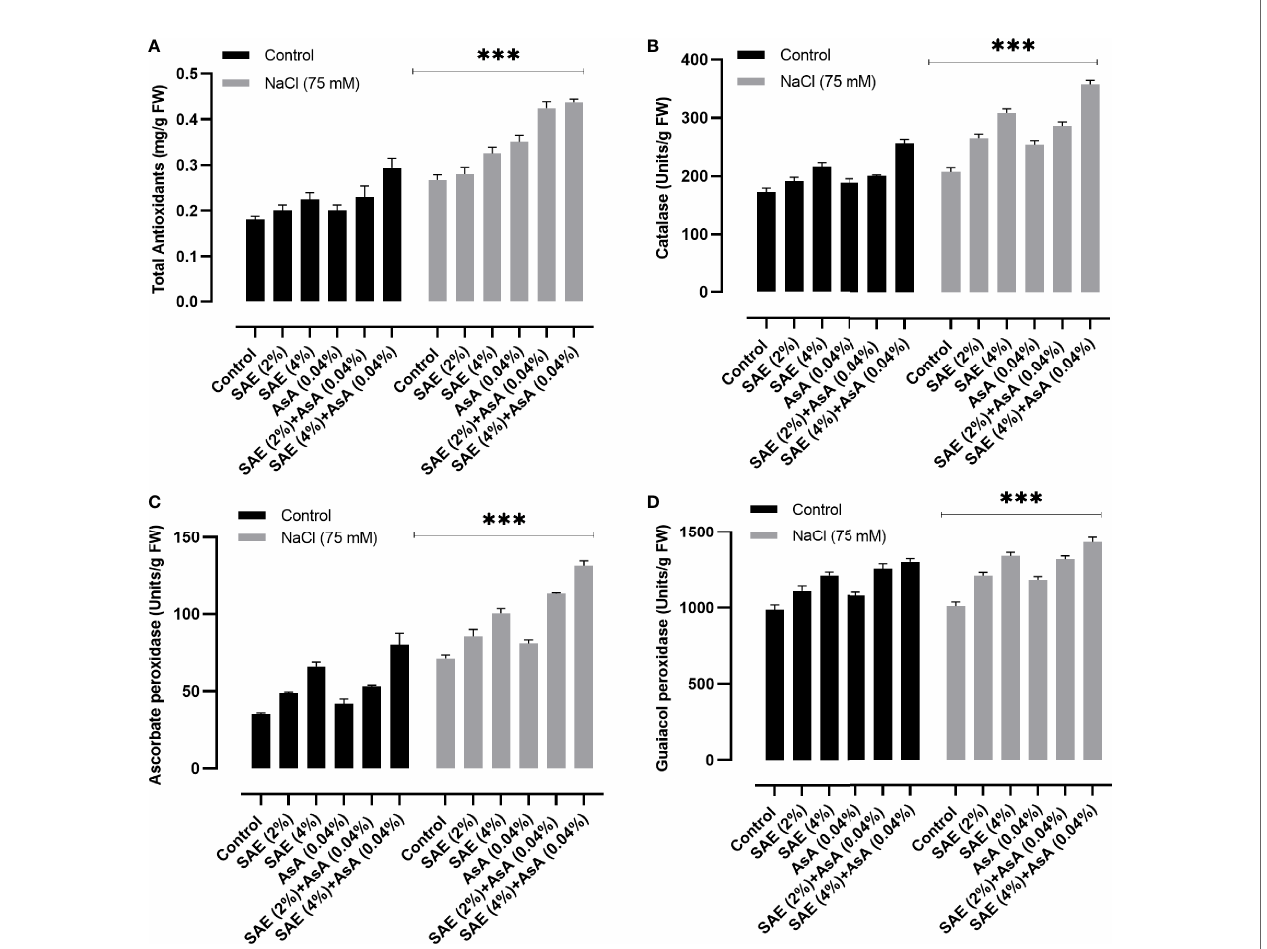
FIGURE 8 | Different antioxidant enzyme activities. (A) Total antioxidants; (B) catalase; (C) ascorbate peroxidase; (D) guaiacol peroxidase. Error bars of quantitative data represent ± SEM (*** p < 0.005). FW, fresh